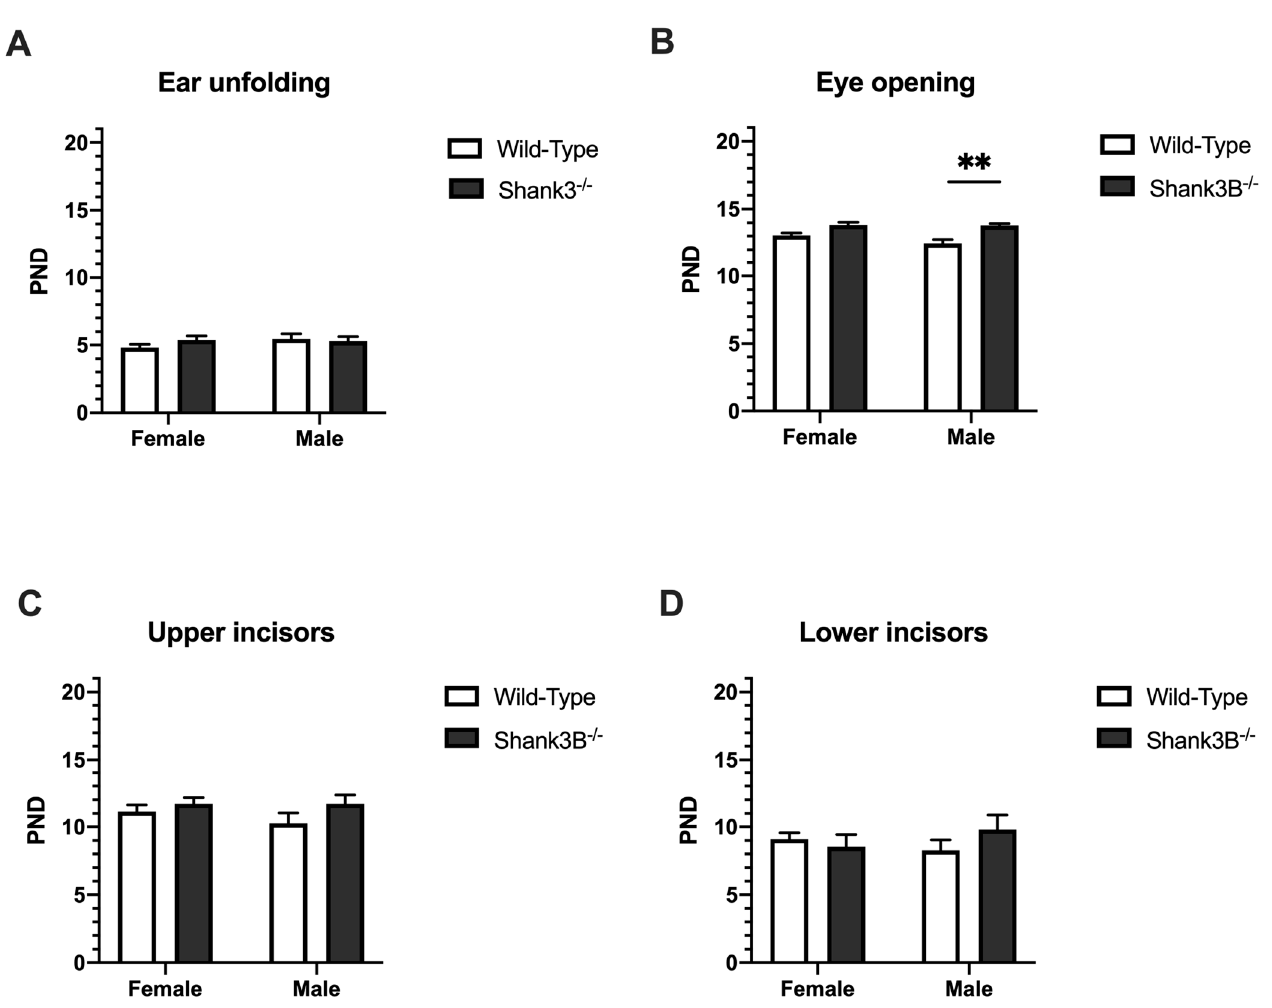
Figure 3. Physical and morphological landmarks of development: ( A ) Ear unfolding. ( B ) Eye opening. ( C , D ) Upper and lower incisors eruption, respectively. PND = postnatal day; ** denotes p < 0.01. Data are shown as mean + SEM Shank3B − / − : ♀ n = 13, ♂ n = 10; Wild-Types: ♀ n = 29, ♂ n = 15.